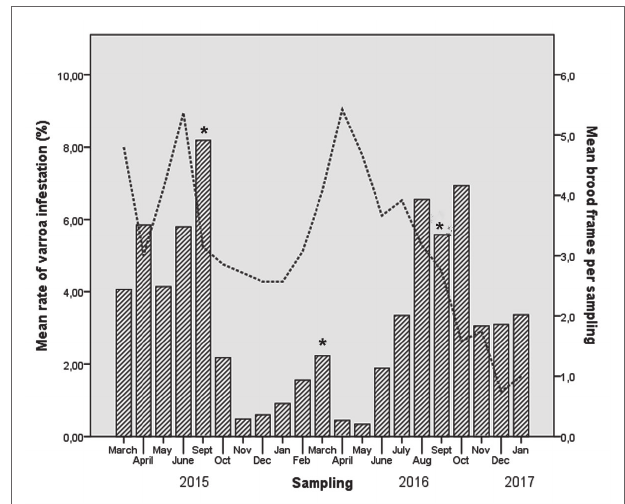
FIGURE 1 | Rates of Varroa destructor infestation (per 100 adult bees) and mean of number of brood frames evolution in each colony, based on monthly sampling. Asterisks mark months when anti- Varroa destructor treatment was applied.